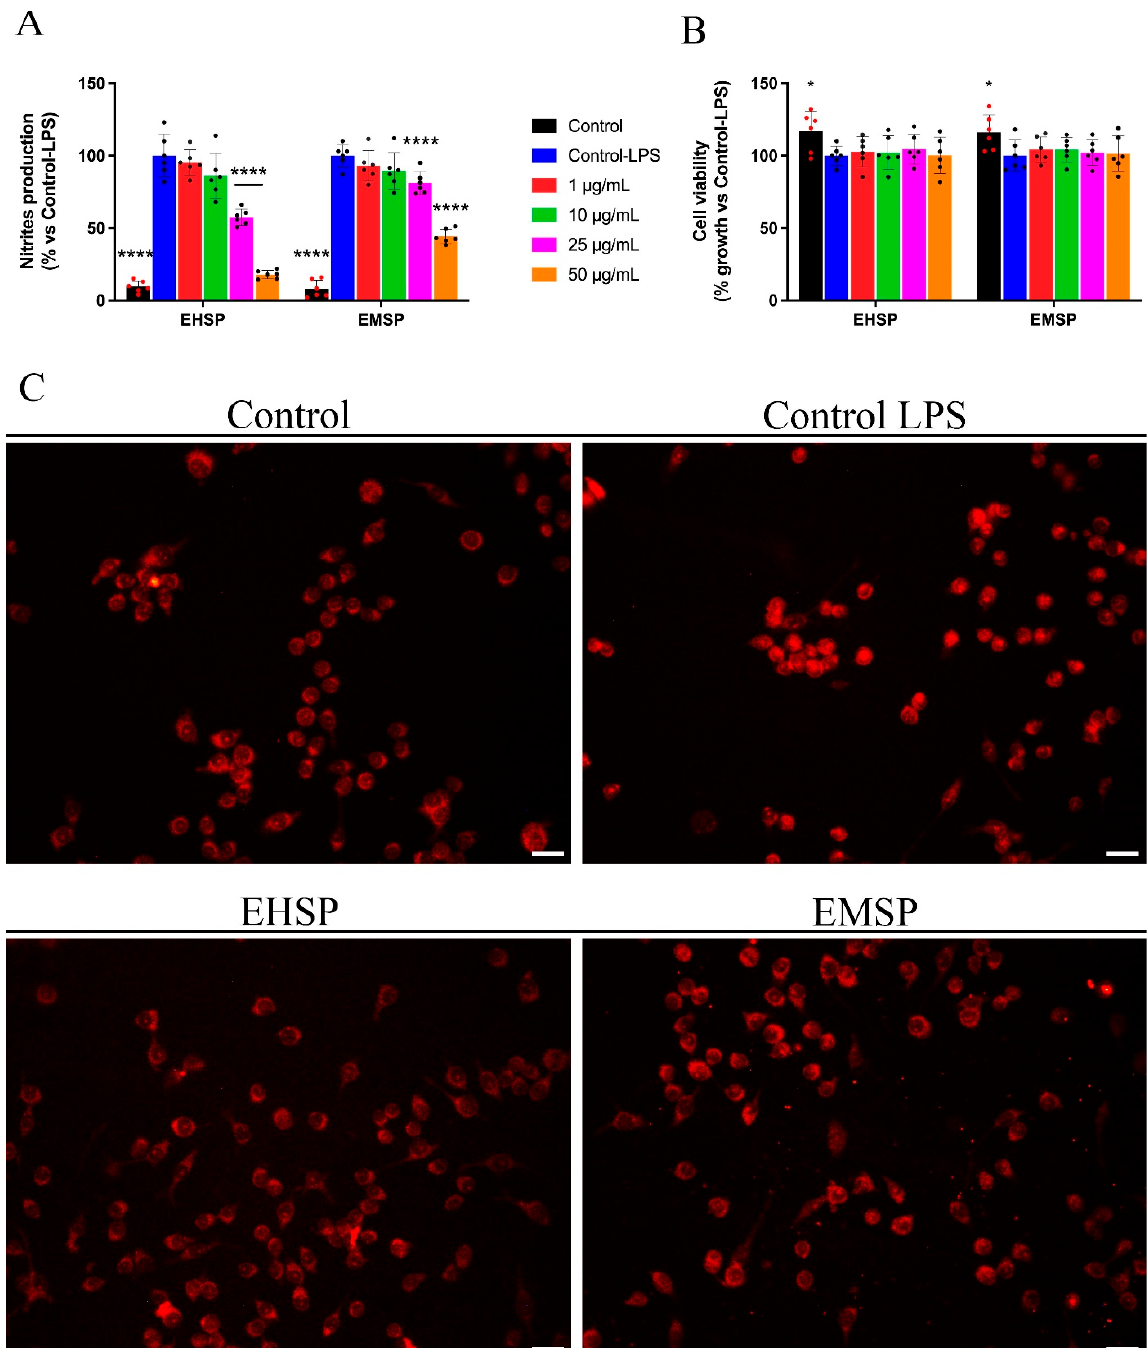
Figure 4. Nitrites production ( A ) and cell viability ( B ) were assessed by Griess assay and MTT assay, respectively, after treatment with LPS-stimulated RAW 264.7 cells with EHSP or EMSP at different concentrations (from 50 μ g/mL to 1 μ g/mL), for 24 h ( n = 6). ( C ) Immuno-fluorescent localization of NF- κ B in RAW 264.7 cells treated for 1 h with DMSO or 1 μ g/mL LPS + DMSO (Control and Control LPS, respectively), 1 μ g/mL LPS EHSP or EMSP (at their IC 50 values, respectively) ( n = 3). Scale bar: 50 μ m. Values represented as mean ± S.D. of three independent experiments. Statistical analysis was performed using one-way ANOVA analysis. * p value < 0.05; **** p < 0.0001.